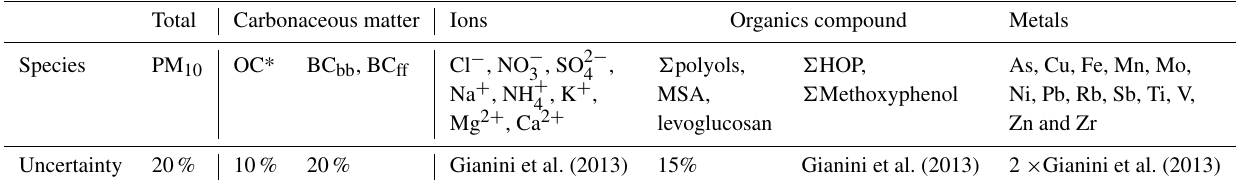
Table 1. Selection of the chemical species used as input variables in the EPA PMF5.0 model and their relative uncertainties. (cid:54) polyols refers to the sum of arabitol, sorbitol and mannitol and (cid:54) methoxyphenol to the sum of the particulate methoxyphenols. The uncertainties in “%” are relative to the sample concentration for the species. Ions Organics compound